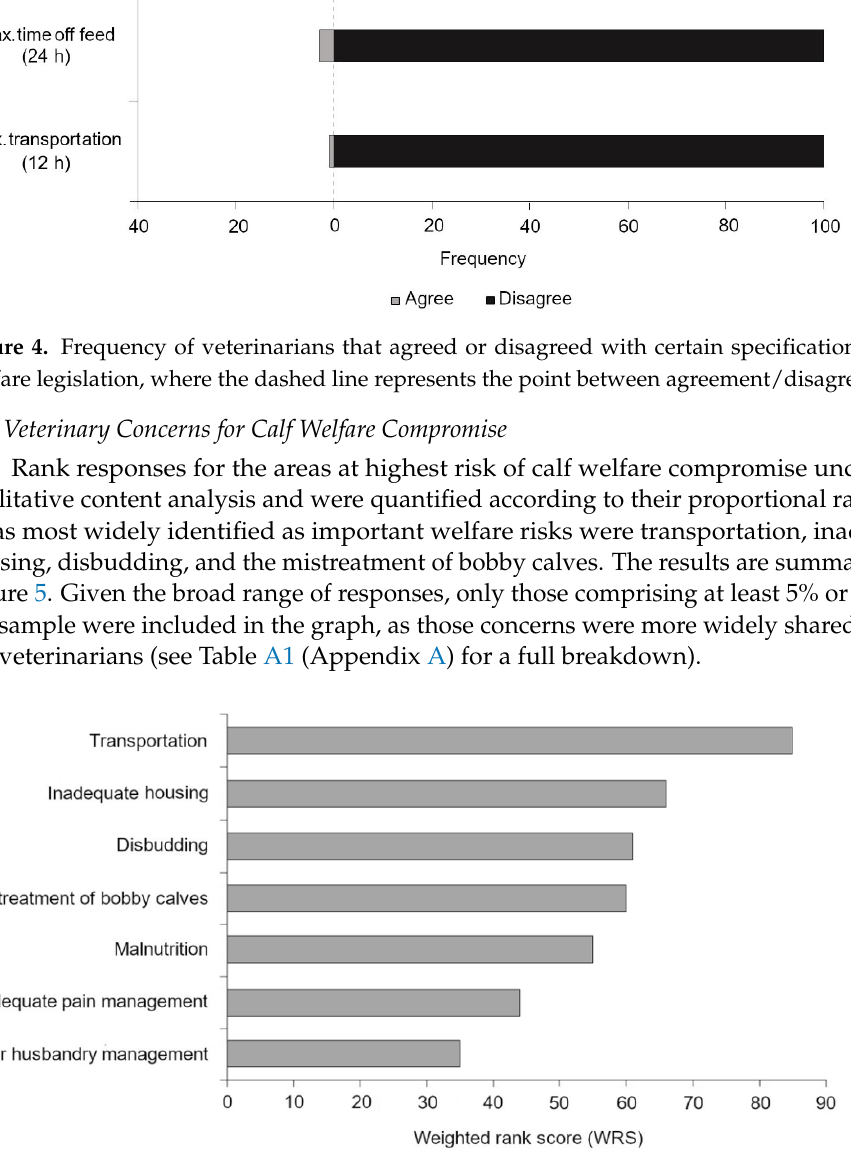
Figure 5. Veterinarians’ concerns on the areas perceived to represent the greatest risk of calf welfare compromise, based on coded qualitative responses. The weighted rank score (WRS) takes into account the frequency of the code and its weighted rank to ensure the greatest concerns had a proportional representation. For each code, the WRS was calculated as the sum of the number of occurrences of the code at each rank, multiplied by the rank’s weight constant. A higher WRS indicates greater concern among veterinarians.